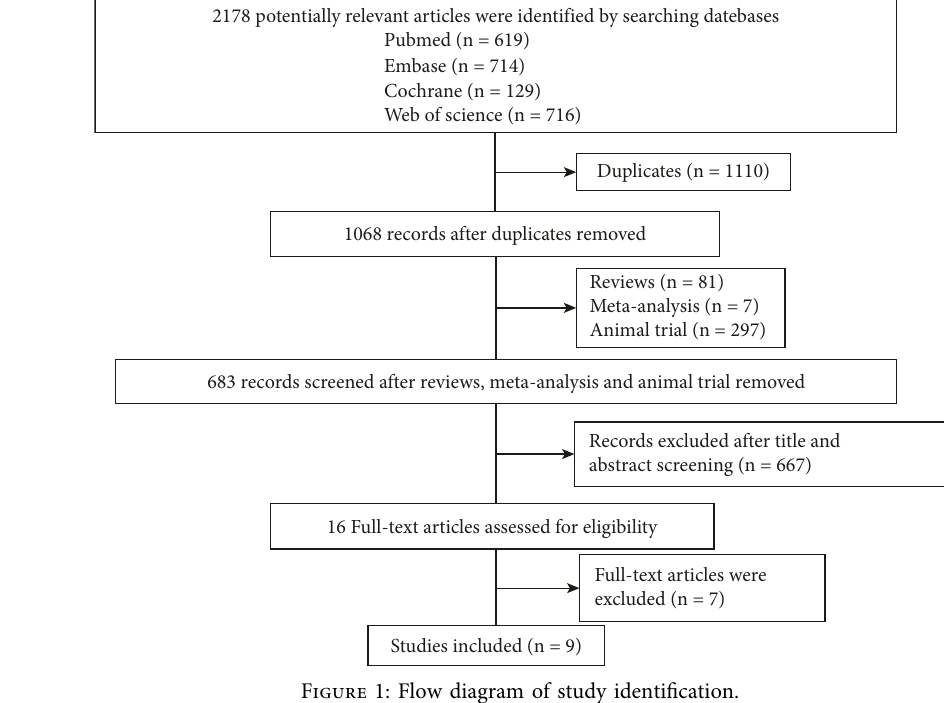
Figure 1: Flow diagram of study identification.